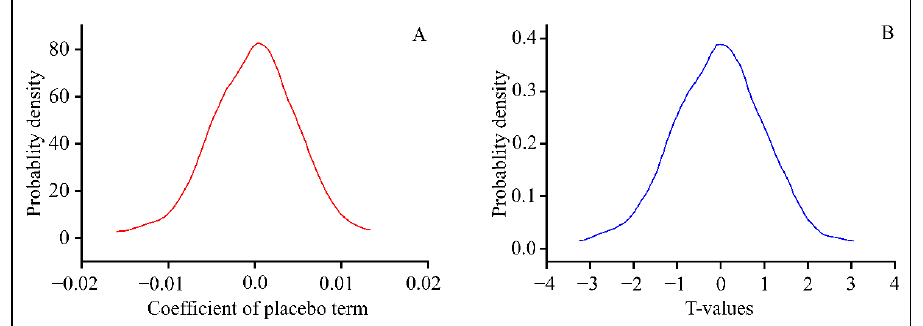
Figure 6. Placebo test density plots (( A ): kernel density estimated coefficients, ( B ): T-values of kernel density estimates).